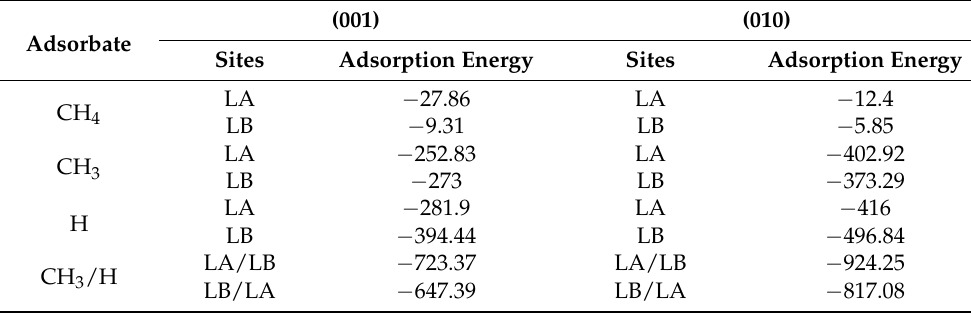
Table 1. CH 4 , CH 3 , H, and CH 3 /H adsorption energy of the Ab surface